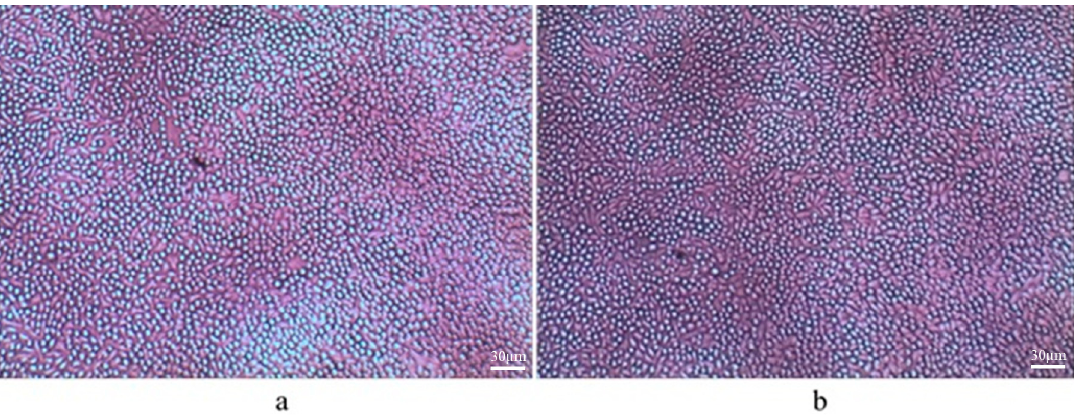
Figure 3. Day 3 cell culture of PEEK / 20 wt% HA / 1.0 wt% CNTs: ( a ) 75% porosity and ( b ) 85% porosity, concentration 1:4.